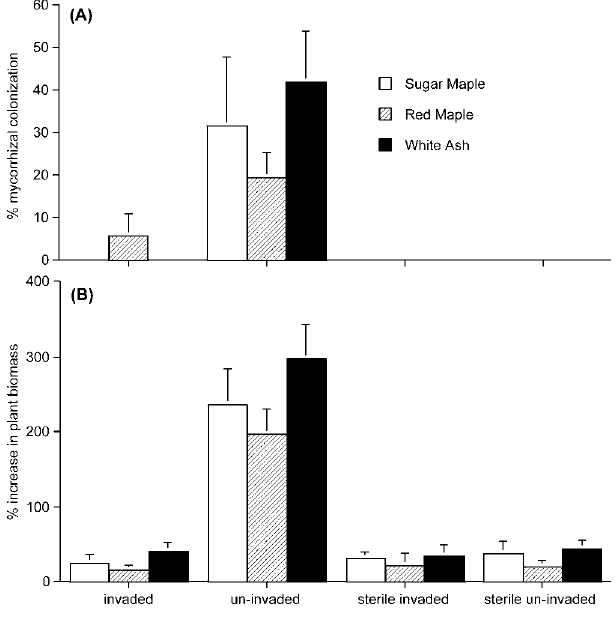
The influence of field soils that were invaded or uninvaded by Al. petiolata ( 6 sterilized) on (A) mycorrhizal colonization ( F sugar maple ¼ 77.7, df ¼ 3,39, p , 0.001; F red maple ¼ 60.5, df ¼ 3,39, p , 0.001; and F white ash ¼ 116.6, df ¼ 3,39, p , 0.001) and (B) biomass accumulation ( F sugar maple